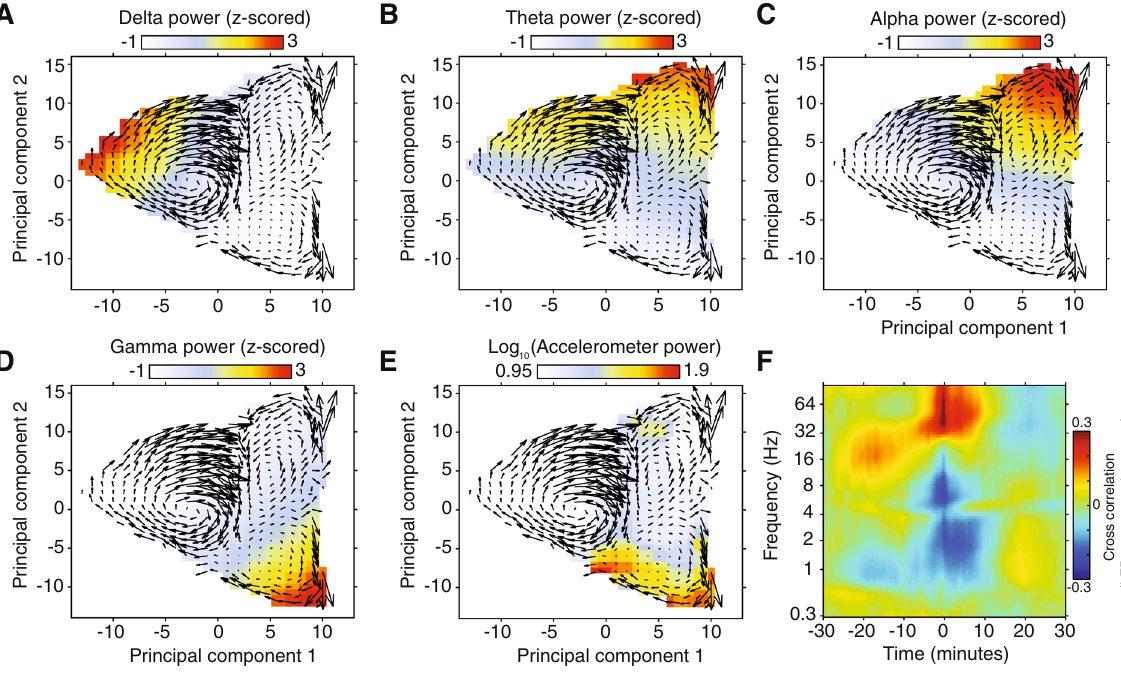
Figure 4. Distribution of LFP and accelerometer power across state space. ( A – D ) Plots represent the session averaged LFP power in delta ( A ), theta ( B ), alpha ( C ), and gamma ( D ) frequency bands across the first two principal components that constitute sleep/wake state space. Overlaid on each plot are mean state space trajectories, illustrating how the brain continuously traverses between sleep/wake states. ( E ) Displays the same as plots A – D , but with accelerometer power. ( F ) The population average cross-correlation of LFP amplitude and accelerometer power, resolved by LFP frequency. Note that animal movement coincides with periods of elevated high frequency amplitude ( > 30 Hz), and reduced low frequency amplitude ( < 14